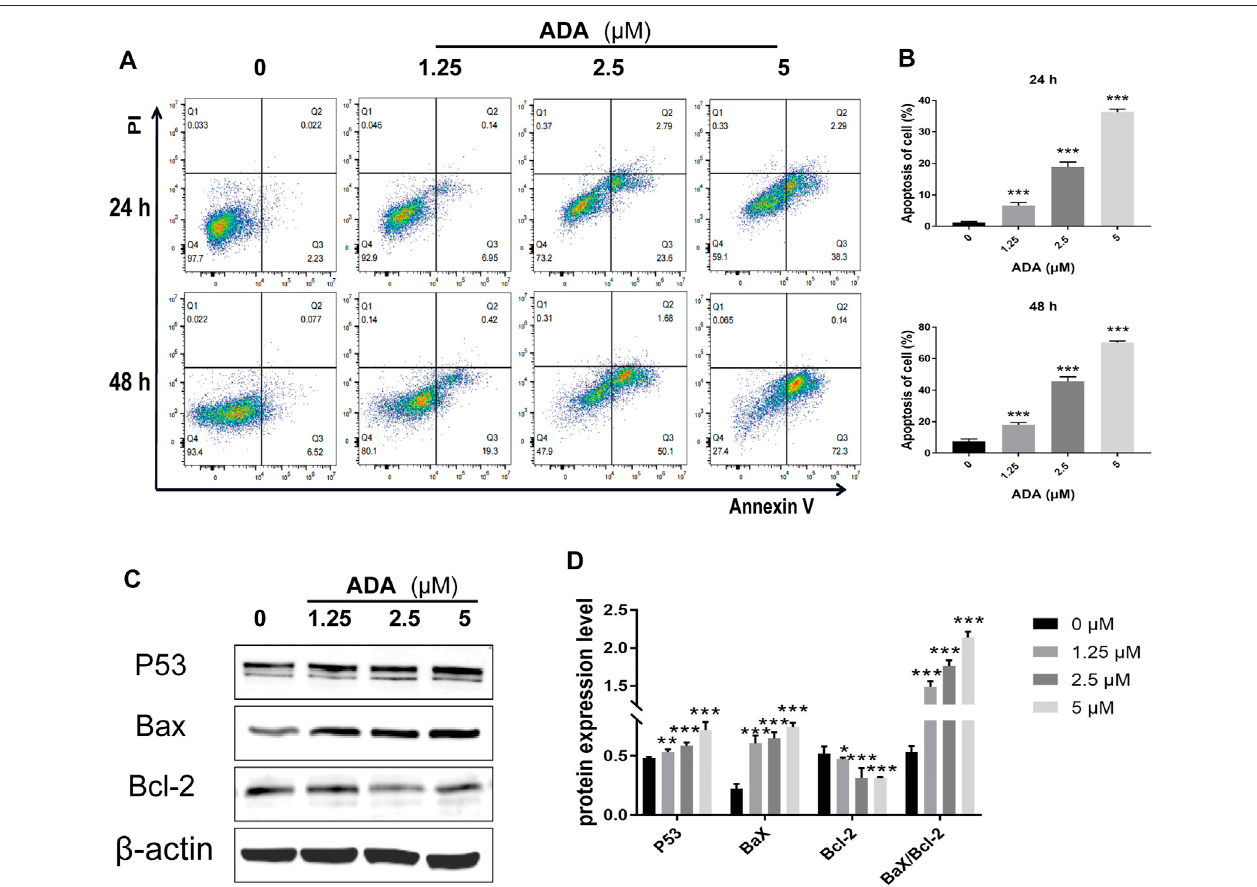
FIGURE4| ADAsigni fi cantlyinducedapoptosisandregulatedtheexpressionofrelatedproteinsinRM-1cells.RM-1cellsweretreatedwithADA(0,1.25,2.5,and 5 μ M)for24or48 hrespectively. (A) CellapoptosiswasdetectedbyAnnexinV-APC/PIdoublestaining. (B) Histogramsshowedtheproportionofapoptosiscellsby fl ow cytometry. (C) Bax, Bcl-2, and P53 protein expression was evaluated utilizing western blotting after 24 h, and (D) histograms showed quantitative protein analyzes and the Bax/Bcl-2 ratio β -actin acted as the loading control. The samples derive from the same experiment and that gels/blots were processed in parallel. Data are articulated as mean ± standard deviation. (* p < 0.05; ** p < 0.01; *** p < 0.001 vs.